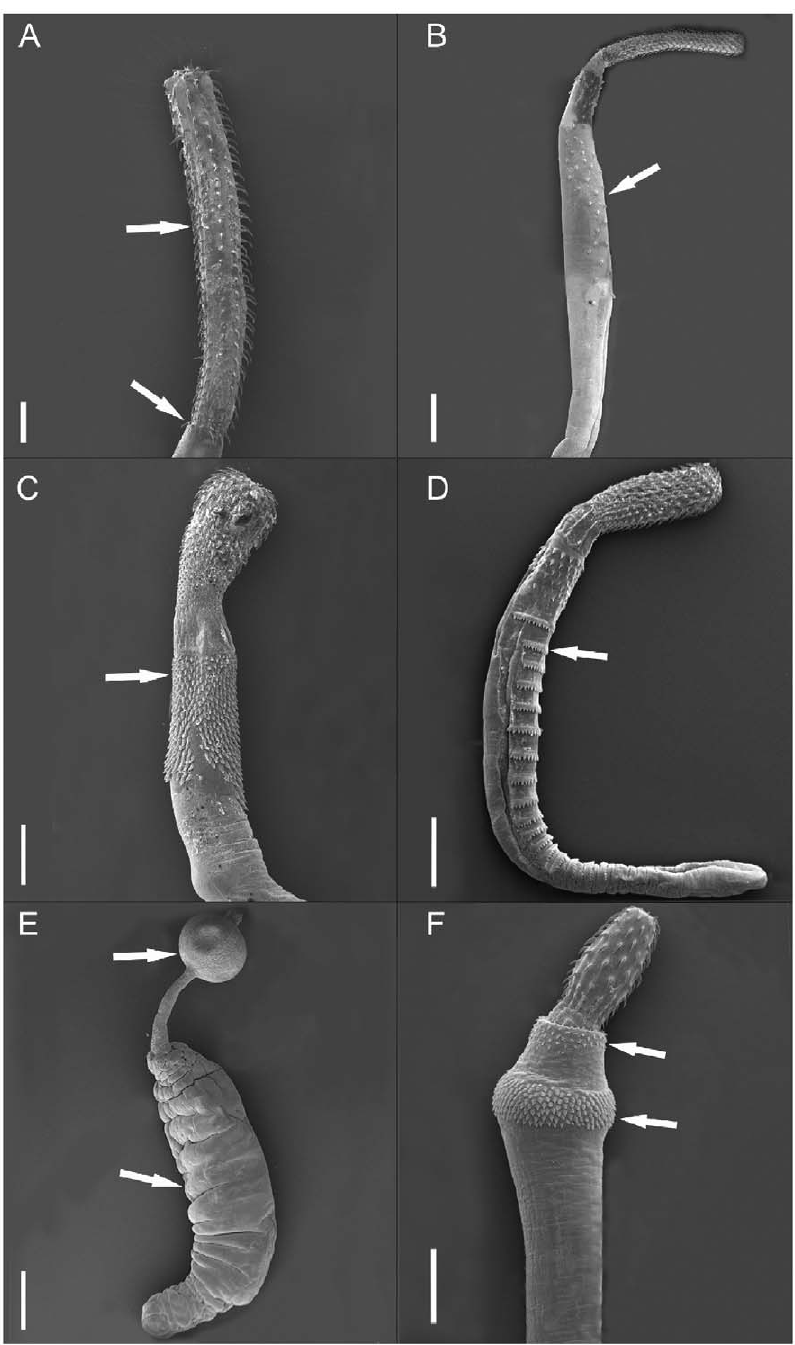
Figure 3. SEM (scanning electron microscope) micrographs of Palaeacanthocephala. (A) Proboscis of male Rhadinorhynchus pristis from Gempylus serpens (Indonesia, Indian Ocean) armed with regular hooks a and basal hook annulus. (B) Praesoma of female R. lintoni from Selar crumenophthalmus (Hawaii, Pacific) with irregular arrangement of trunk hooks. (C) Praesoma of Gorgorhynchoides golvani from Platycephalus arenarius (Indonesia, Indian Ocean) regular arrangement of surface hooks. (D) Habitus of Serrasentis sagittifer from Platycephalus arenarius (Indonesia, Indian Ocean) with hooks are transformed into strong plates arranged as combs. (E) Habitus of Pomphorhynchus laevis from Platichthys flesus (Baltic Sea) shows any trunk hooks on bulb, neck and trunk. (F) Praesoma of Bolbosoma vasculosum from Lepturacanthus savala (Indonesia, Indian Ocean) formed in the shape of a bulb, and armed with regular hooks which are arranged in two rings. Scale bars: A 400 m m, B, D, F, 200 m m, E 100 m m. doi:10.1371/journal.pone.0028285.g003 represent a different class within the phylum Acanthocephala. derived follow the Polyacanthocephalans as parasites of fishes and The more derived Palaeacanthocephala, including the Echinor- crocodiles, sister to the Eoacanthocephalans (in fish, amphibians hynchida and Polymorphida, are arranged in a paraphyletic and reptiles) from the aquatic environment. This result is assemblage. Both orders demonstrate high morphological diver- consistent with the hypothesis that the Polyacanthocephala